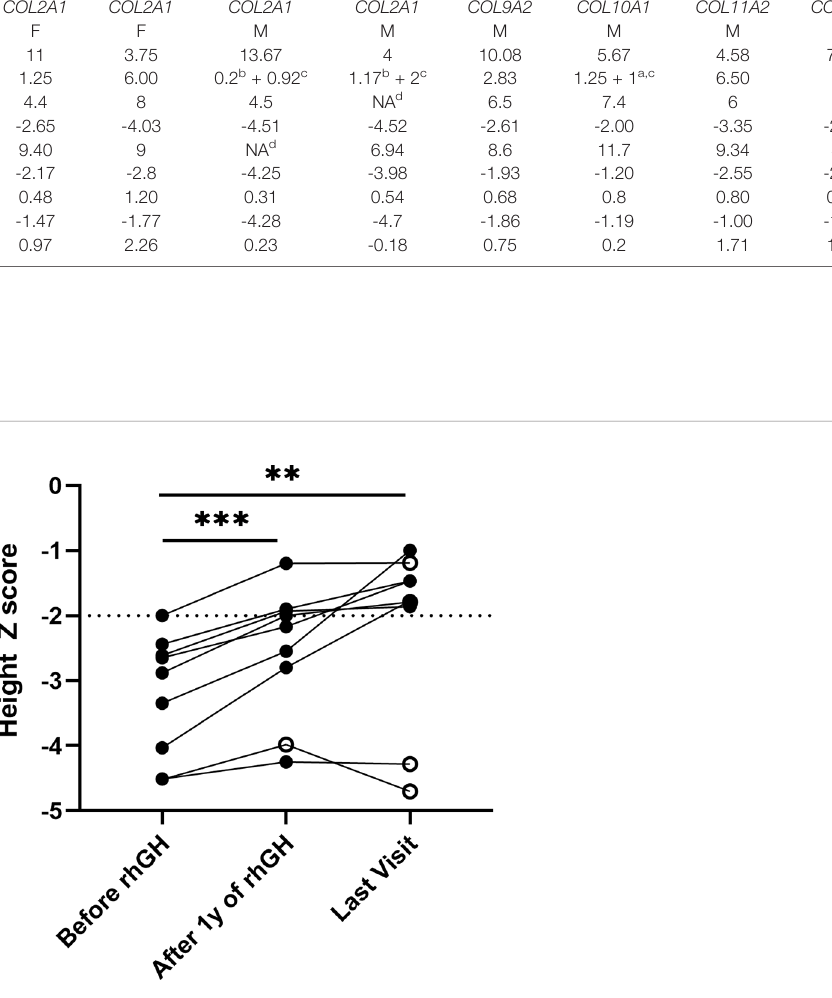
FIGURE 2 | Height Z score in patients with collagenopathies with rhGH treatment. The median follow-up time was 2.25 years with a range of 1.12 to 6.50 years. Solid black dots indicate continued treatment up to the last follow-up, and hollow black dots indicate discontinuous treatment, **p <.01, ***p